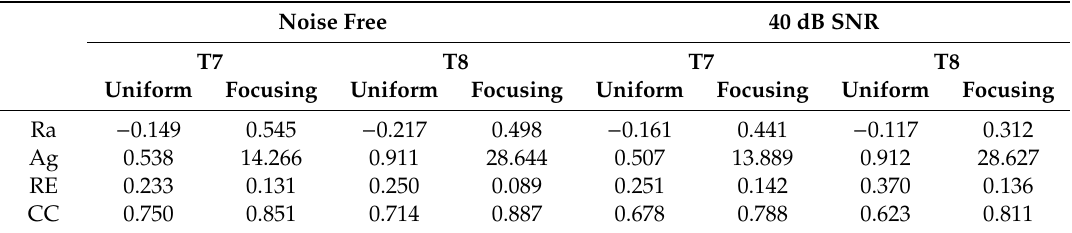
Table 2. Quantitative analyses of reconstruction results shown in Figure